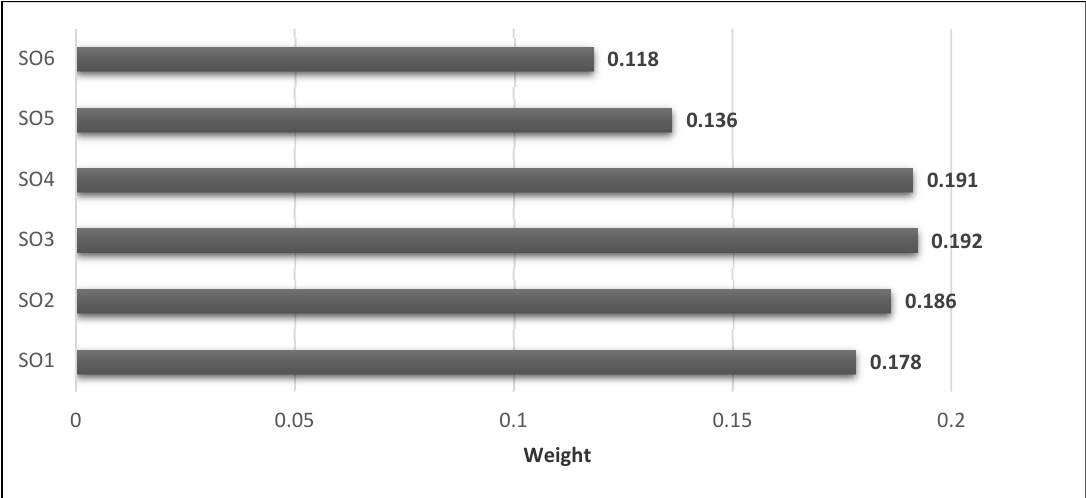
Figure 5. Ranking of green innovation sub-criteria with respect to the environmental (EN) criteria. 4.2.3. Overall Green Innovation Sub-Criteria Results Table 7 shows the priority order of the overall sub-criteria based on the goals of this study. The final weights of the seventeen sub-criteria were obtained by multiplying the local weight of the sub- criteria with those of each green innovation criterion. The analysis showed that the commitment to developing an environmental management system (EN1) sub-criterion achieved the highest weight at 0.0720 (7.20%). The financial availability of the green innovation (EC1) sub-criterion achieved the second-highest weight at 0.0718 (7.18%). Investment in research and development for green practices (EC2) was the third most vital green innovation sub-criterion.